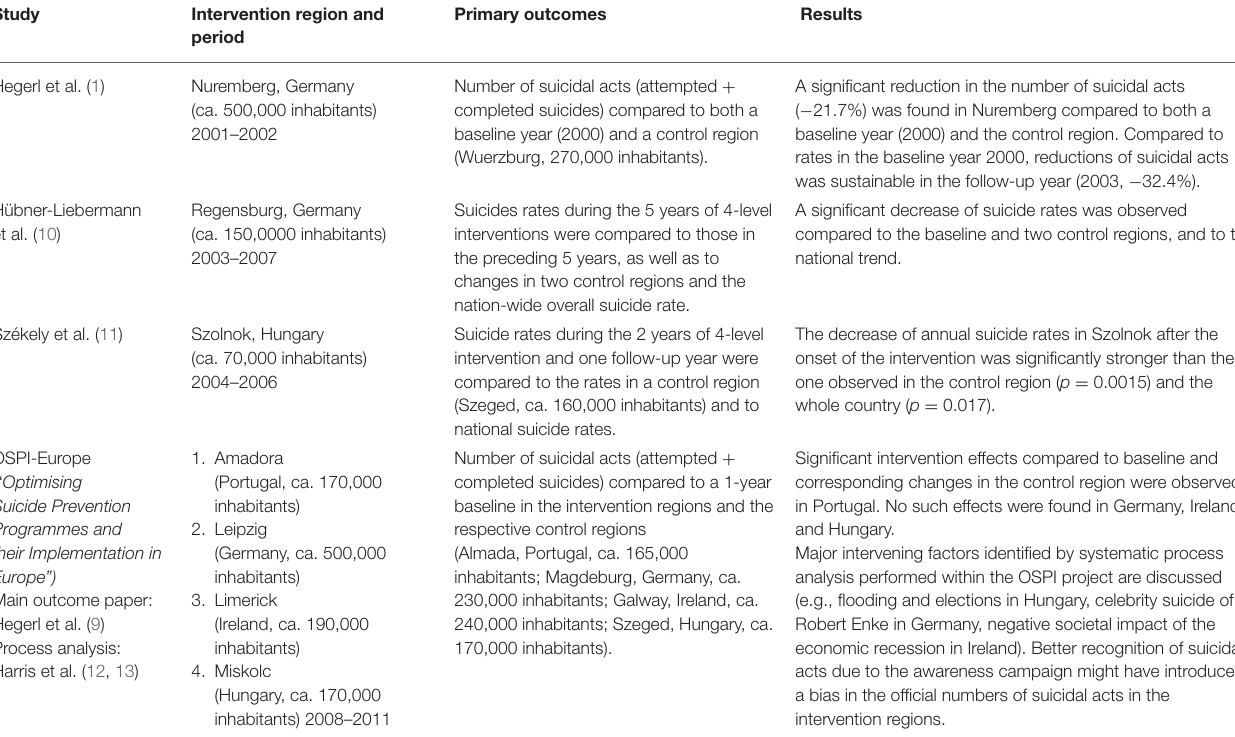
TABLE 1 | Evidence supporting the 4-level intervention concept (controlled studies